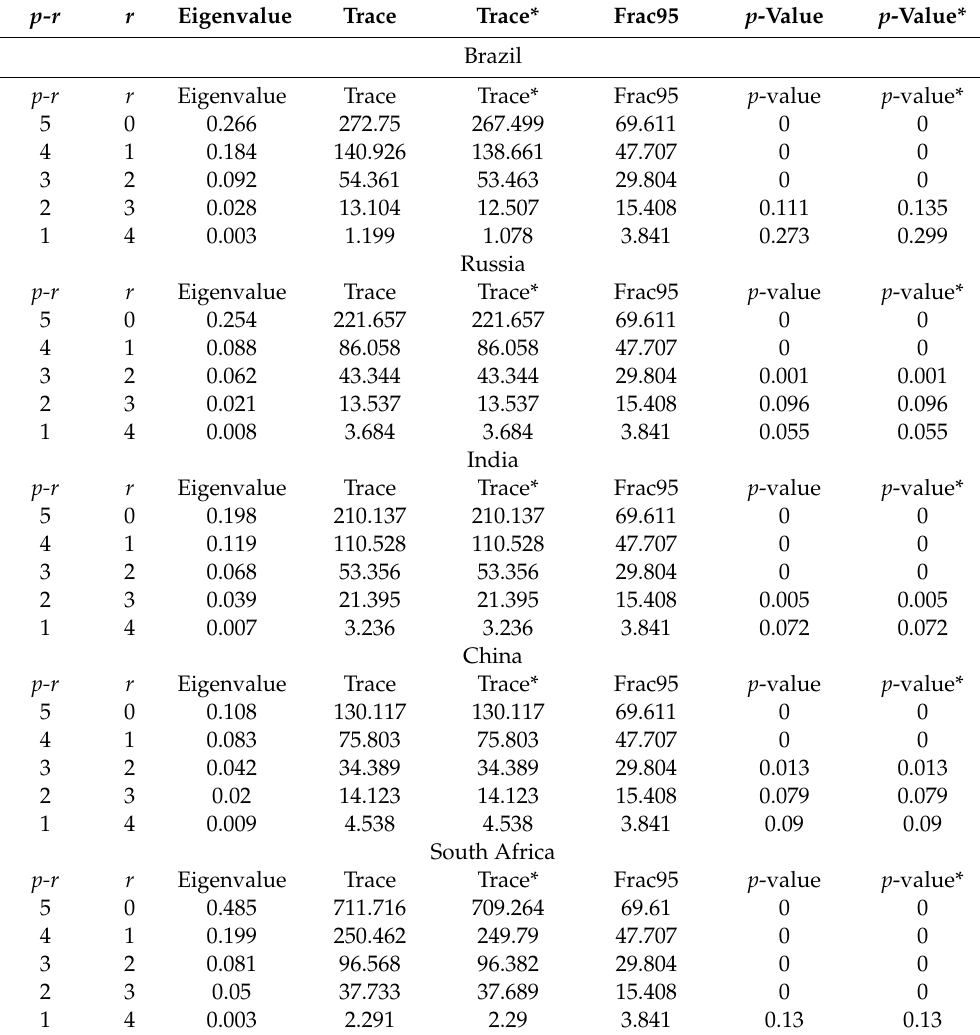
Table A3. Johansen trace